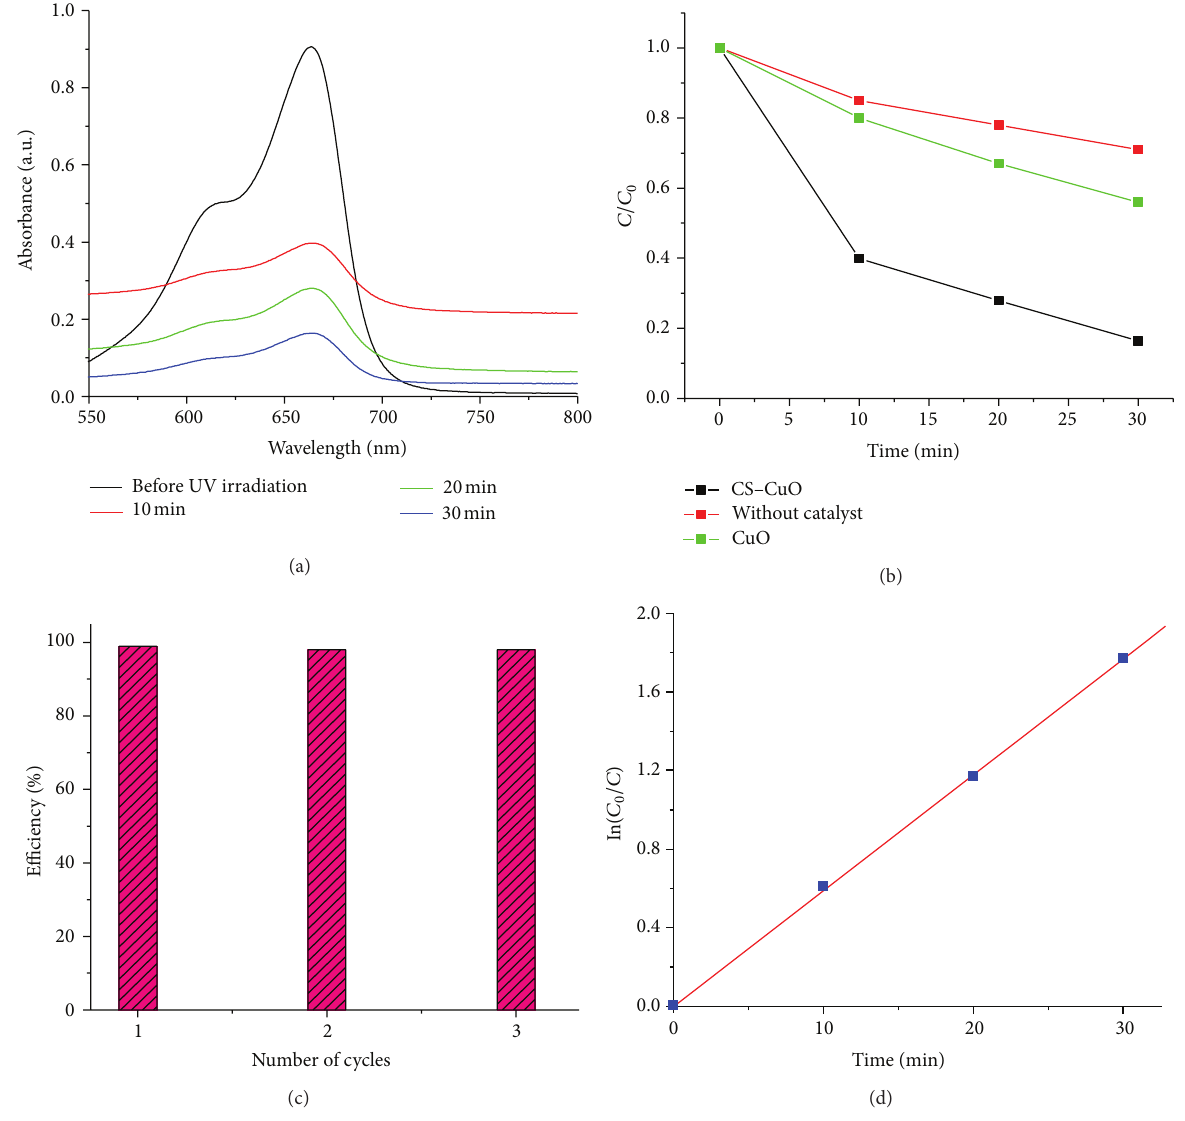
Figure 6: (a) UV-visible spectra of the MB solution in the presence of CS-CuO hybrid at different UV-irradiation time, (b) photodegradation of the MB dye, (c) photostability of the hybrid after three cycles, and (d) first order kinetic model for the photodegradation of MB.